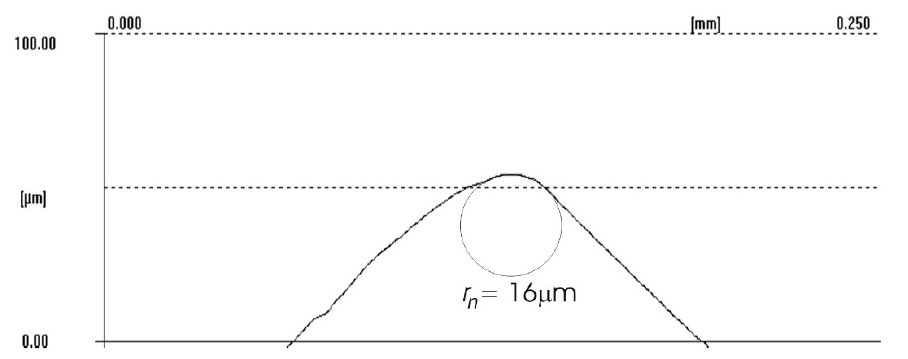
Figure 20. Cutting edge radius r n of the new cutting insert.